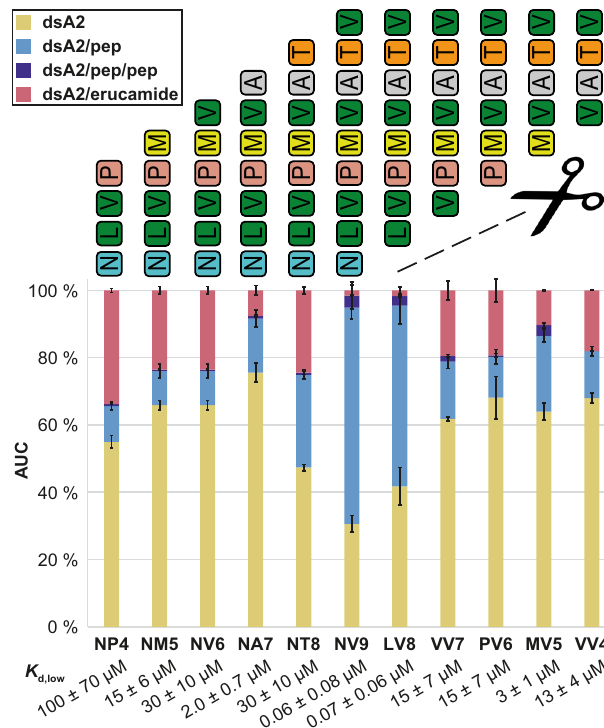
Fig. 5 Binding of charge-reduced NV9 variants. a The AUC is determined over the entire spectrum for the respective mass species, which is depicted along with error bars that represent the corresponding standard deviation. “ dsA2 ” corresponds to the empty complex, “ dsA2/pep ” to dsA2 bound to one peptide, “ dsA2/pep/pep ” to dsA2 bound to two molecules of this certain peptide and “ dsA2/erucamide ” to dsA2 bound to erucamide respectively. By modifying only one terminus (Ac-NV9 and NV9-NH 2 ), the af fi nity of the peptide to dsA2 changes only marginally, but if the charges on both termini are neutralized (Ac-NV9-NH 2 ), the peptide binding is greatly reduced. The corresponding K d,low is shown for respective peptides. b Representative charge-deconvoluted spectra of the distinct protein and protein – peptide complex species recorded at 10 V. Olive and dark green correspond to the free β 2 m domain and heavy chain respectively. Teal corresponds to a free heavy chain still attached to a peptide. The different complexes are assigned in yellow (empty dsA2), coral (dsA2/erucamide), light blue (dsA2/pep), and dark blue (dsA2/pep/pep). In contrast, loss of the C -terminal valine (NT8) strongly decreases af fi nity ( K d,low = 30 ± 10 µM). The erucamide is no longer fully displaced by NT8, only a small fraction of the protein – peptide complex is resistant to 50 V acceleration voltage, and no sig- ni fi cant stabilization effect ( Δ T m = 3.1 ± 0.6 K) is measured. Thus, the interactions of the C -terminal amino acid, an anchor residue, are more important for overall binding than those of the N - terminal amino acid. However, when the second amino acid from the N -terminus, leucine, is also eliminated (VV7), af fi nity and position is an anchor residue. Strong binding between peptide and A2 only occurs if both B and F pockets are occupied with peptide side chains. Still, the difference between GV9 and LV8 points towards an additional contribution of the other amino acids that is in sum larger than the N -terminal contribution.